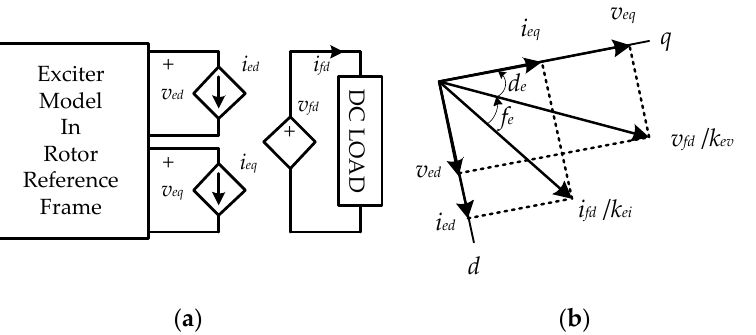
6 of 19 Figure 4. Equivalent circuit of the exciter.